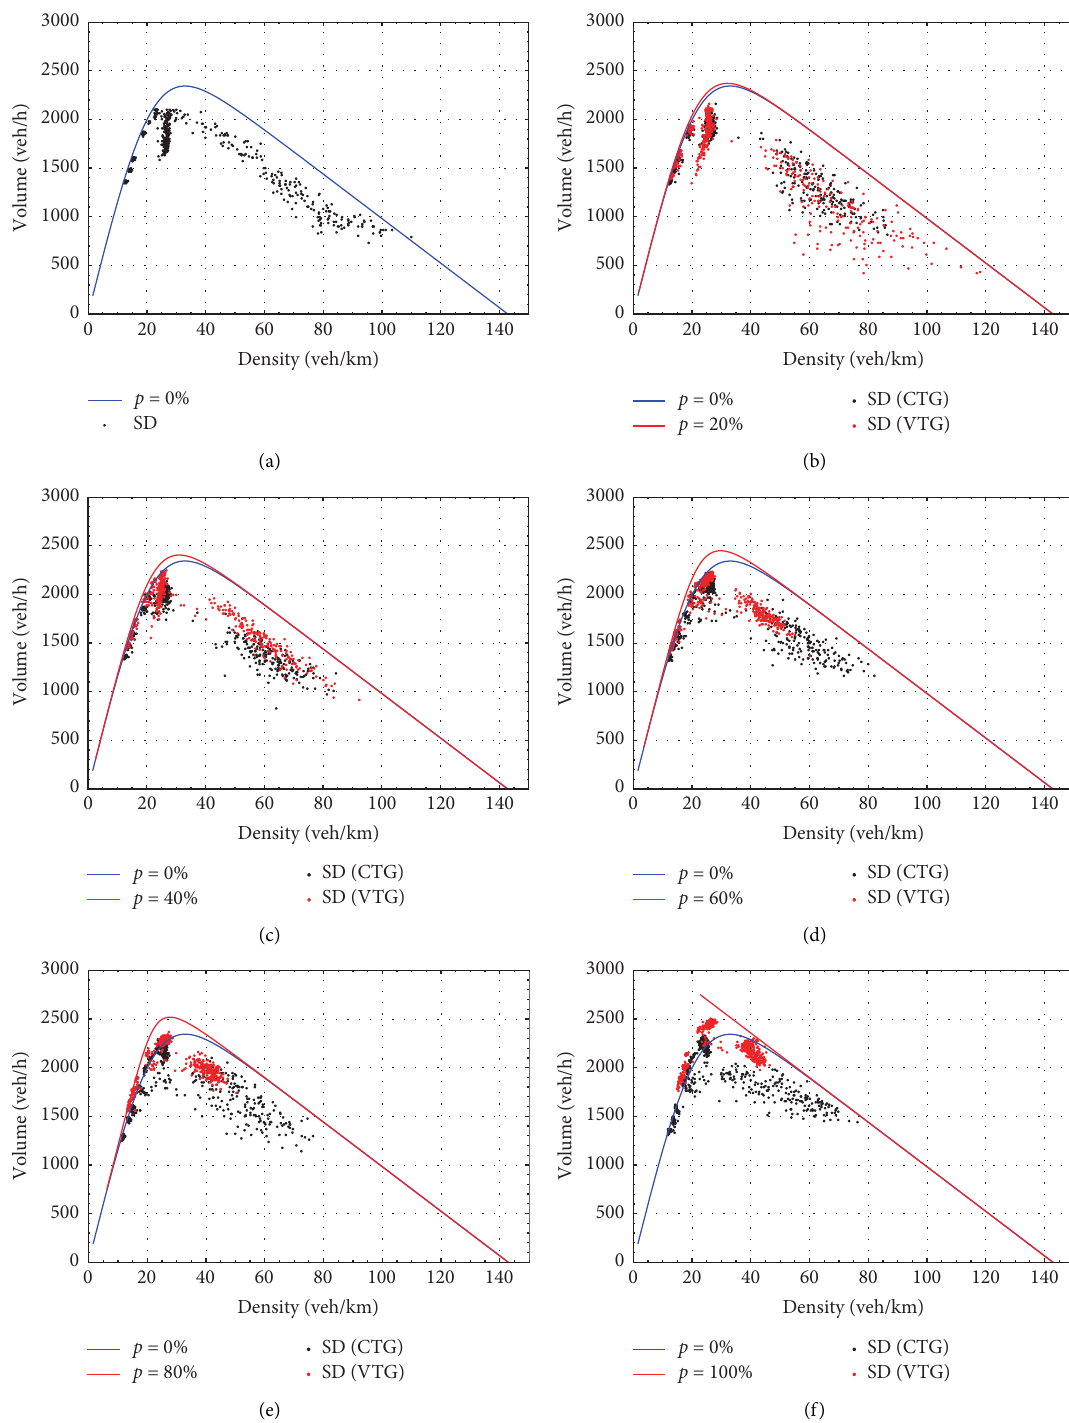
Figure 10: Fundamental diagrams from simulating results of different market penetration rates of ACC vehicles with different desired time gap policies (SD: simulation